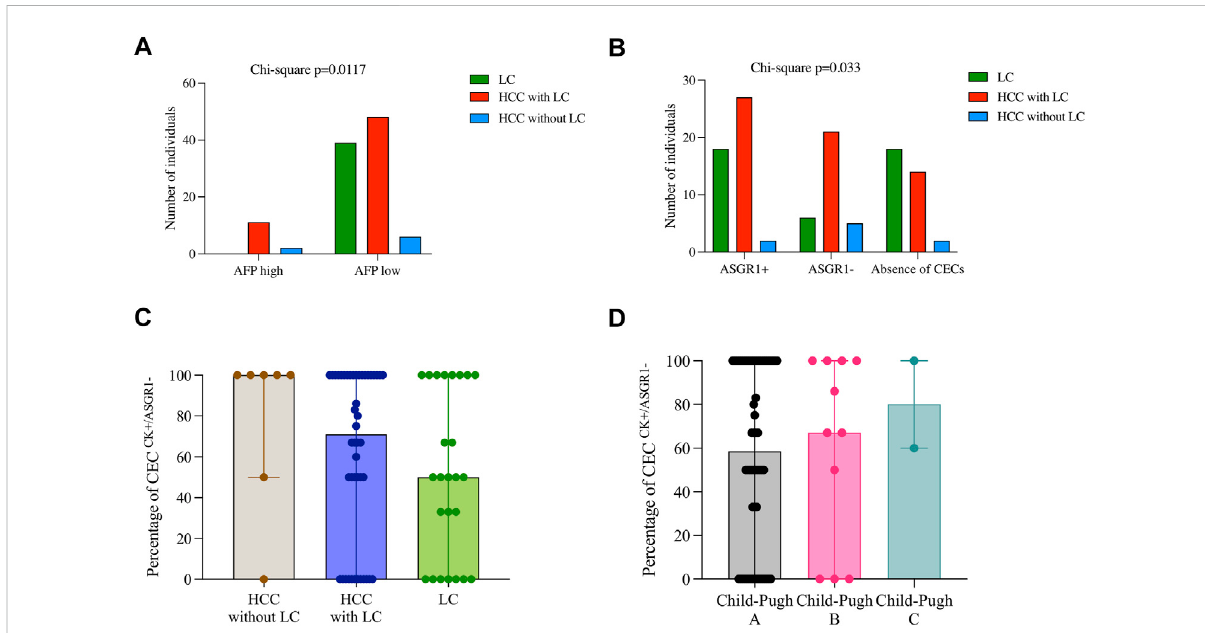
FIGURE 5 Relationship between CEC characterization and clinical and pathological features in patients with liver cirrhosis or HCC. (A) Shows AFP levels divided by high ( > 400 ng/ml) and low ( < 400 ng/ml) for three groups of patients: LC = liver cirrhosis; HCC of cirrhosis etiology and HCC of other a etiology. (B) Shows frequency distribution of CECs for the same groups of patients. (C,D) Represent percentages of CECs with lack of ASGR1 expression for either the three previous group of patients (C) or Child-Pugh scores (D) . p values for Chi-Square tests are shown for graphs (A,B) . No signi fi cant differences are shown in C and D for Kruskal Wallis